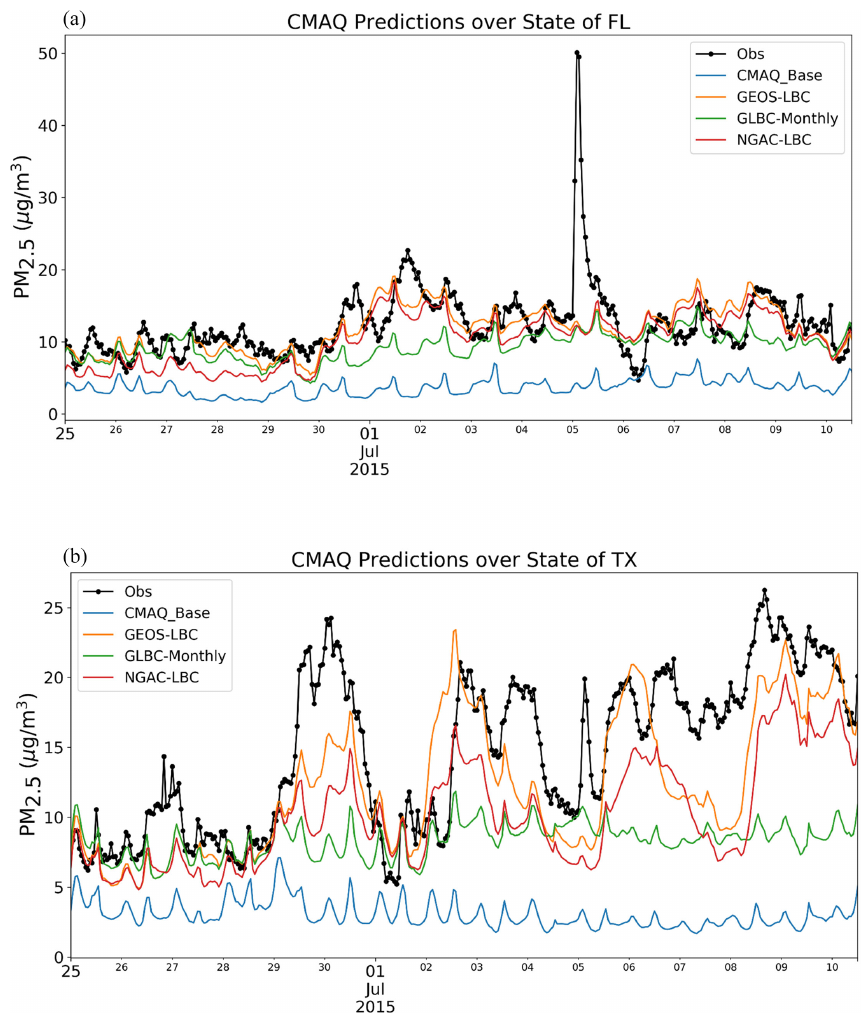
Figure 6. Time-series PM 2 . 5 comparisons over the states of Florida (FL) and Texas (TX). All the times are in